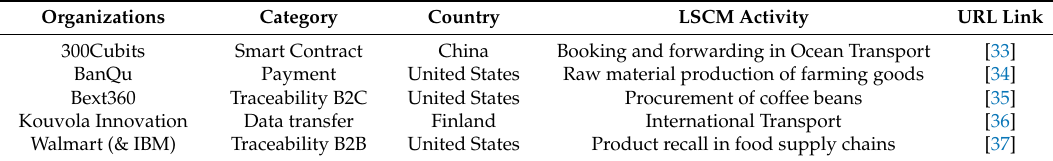
Table 1. Final case selection of blockchain use cases in